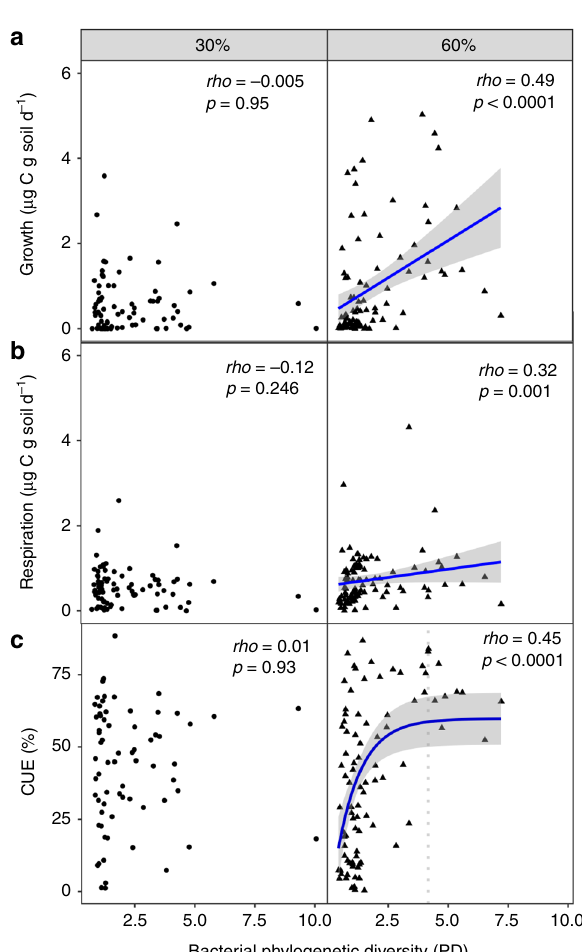
Fig. 2 Relationship between bacterial diversity and growth, respiration and CUE. Relationship between bacterial phylogenetic diversity (PD) and growth ( a ), respiration ( b ), and CUE ( c ). Microcosms incubated under 30 and 60% WHC are shown on the left and right panels, respectively. Monotonic relationships between the diversity metric and growth, respiration or CUE are evaluated with Spearman correlation and when signi fi cant are indicated with a blue line. We fi t linear curves for growth and respiration. Biologically, CUE cannot be >100%, thus we fi t a saturating curve to the CUE data. The vertical dashed line indicates the threshold at which there is no more signi fi cant relationship between bacterial diversity (PD) and CUE. Shaded area denotes 95% con fi dence intervals. There were 84 and 92 replicates for 30% and 60% WHC,